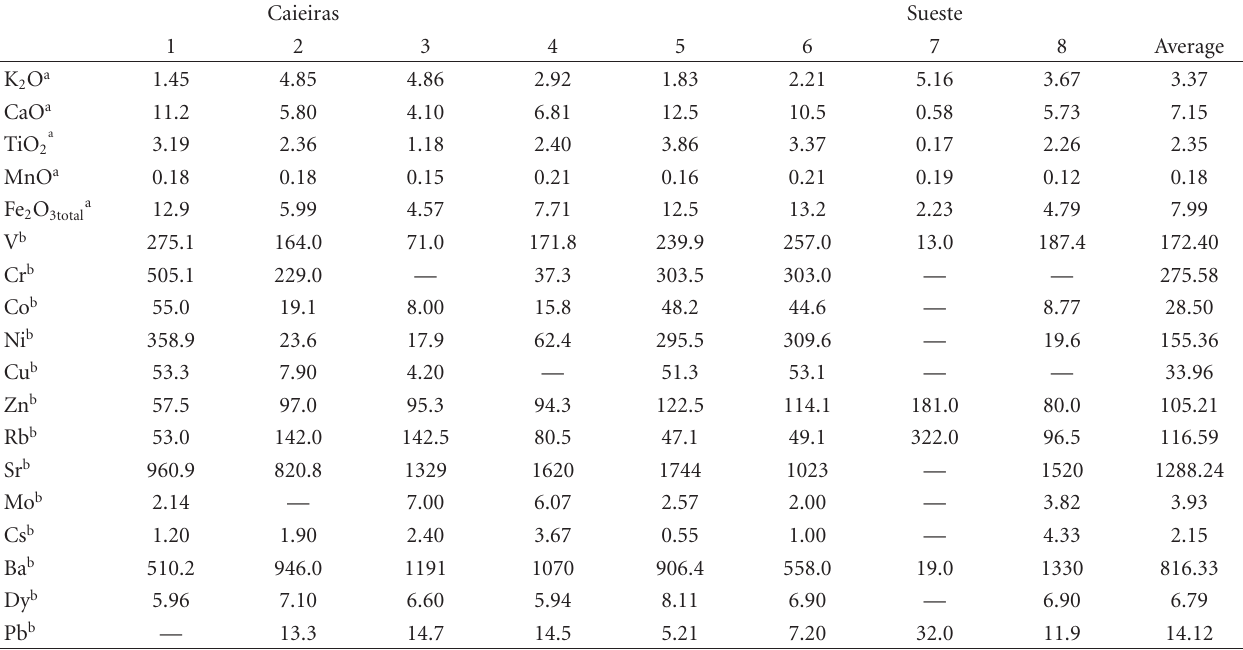
Table 6: Representative chemical composition of alkaline rocks from Caieiras (1 to 5) and Sueste (6 to 8).